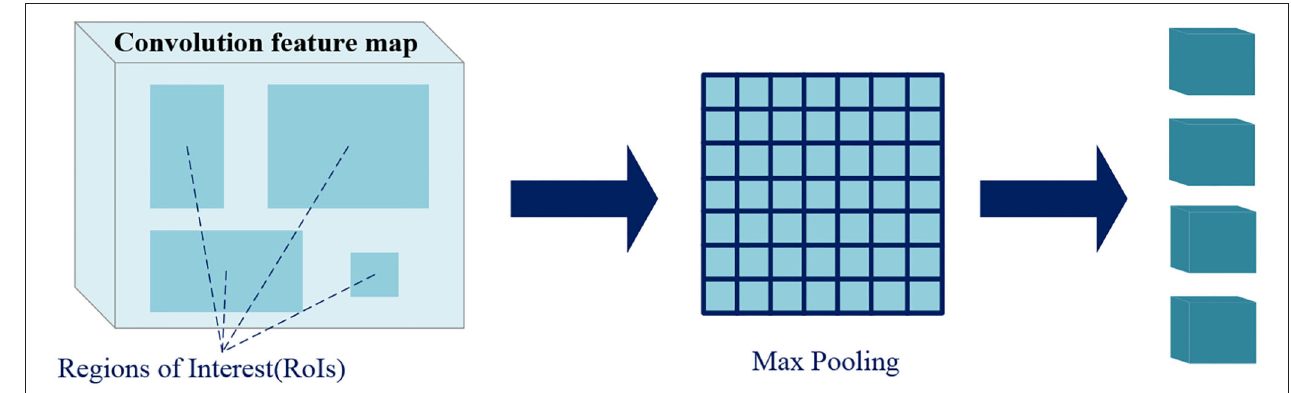
FIGURE 7 | Region of interest (RoI) pooling.